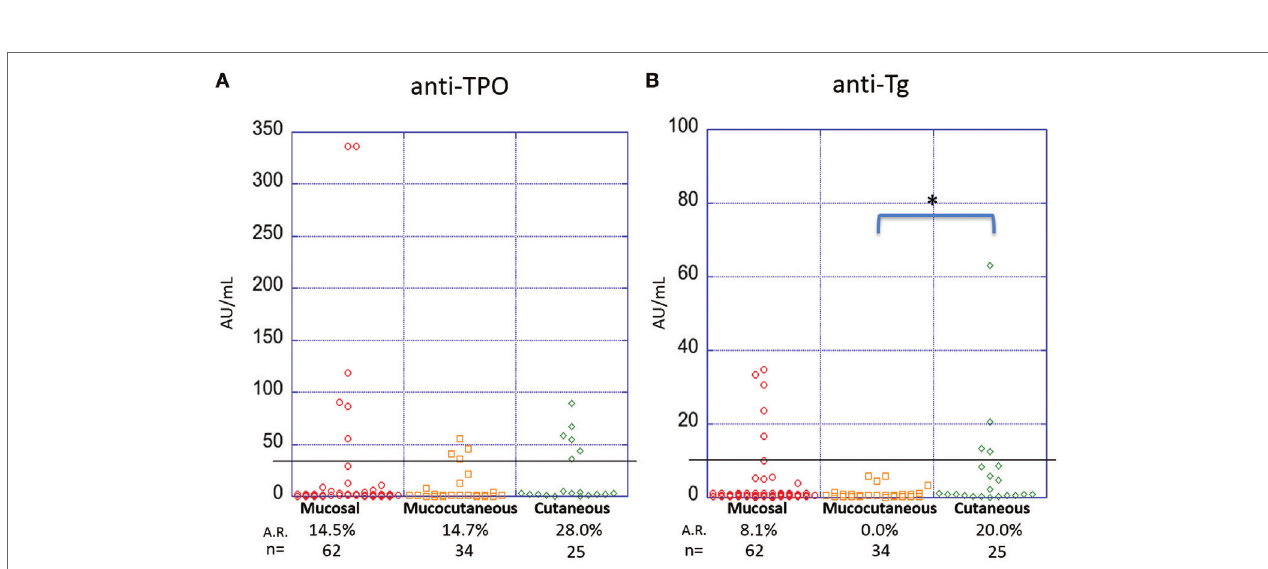
FigUre 4 | Activity rates of anti-thyroid peroxidase (anti-TPO) and anti-thyroglobulin (anti-Tg) based on morphology. Individual dots represent anti-TPO and anti-Tg levels (in AU/ml) in pemphigus vulgaris patients subgrouped on the basis of lesion morphology for (a) anti-TPO and (b) anti-Tg antibodies (* p < 0.05). Abbreviation: A.R., activity rate. Anti-TPO and anti-Tg antibody rates were modeled as a function of disease morphology using a generalized estimating equations logistic regression model.